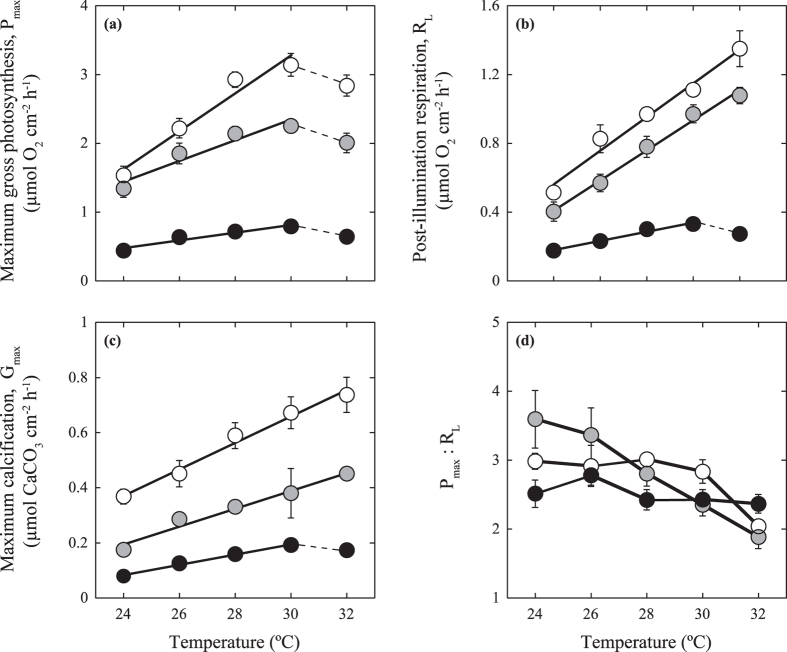
Scaling metabolic quotients (Q10) for photosynthesis, respiration and calcification rates.The symbols represent mean values ± SEM (n = 4–8) for (a) gross photosynthesis (Pmax), (b) post-illumination respiration (RL), (c) maximum calcification rates (Gmax), and (d) the photosynthesis to respiration ratio (Pmax:RL). The trend lines represent linear regression fits (see text for details). Dashed lines indicate metabolic rate decay. Symbols: white circles indicate rhodoliths, grey circles indicate articulated algae, and black circles indicate CCA.